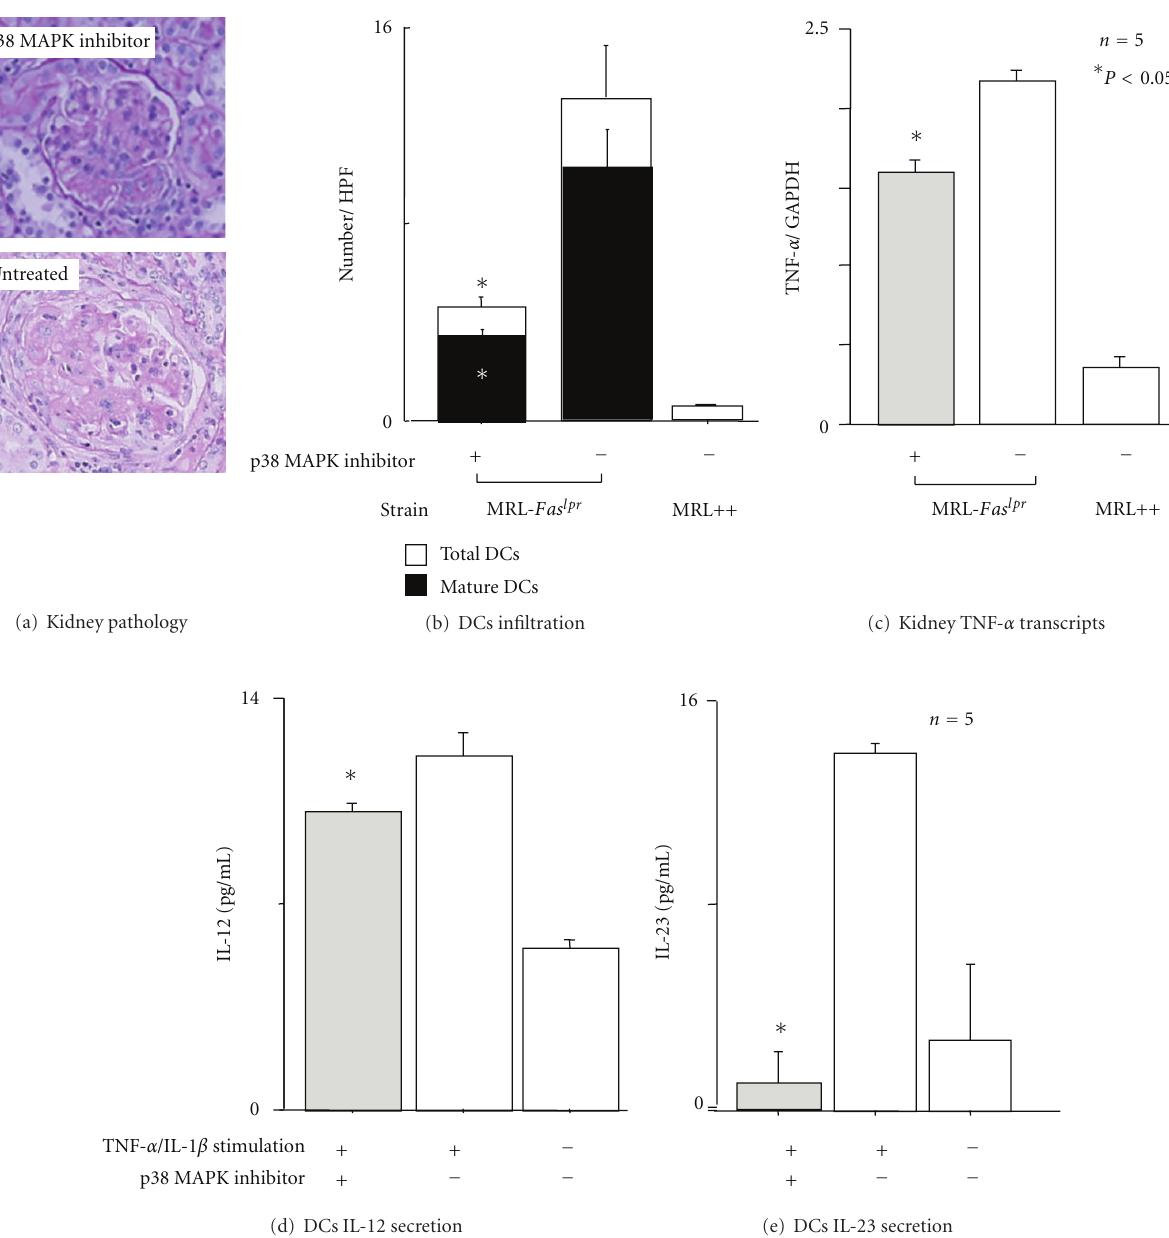
Figure 1: p38 MAPK plays an essential role in the lupus nephritis in MRL- Fas lpr mice. (a) p38 MAPK inhibitor ameliorates kidney injury in MRL- Fas lpr mice. (b) The number of CD11c + cells and CD11c + CCR7 + mature phenotype was decreased by the inhibition of p38 MAPK in the kidney. (c) The transcripts of TNF- α were reduced by the administration of p38 MAPK inhibitor. ((d) and (e)) p38 MAPK is central for the production of IL-12 and IL-23 on DCs in MRL- Fas lpr